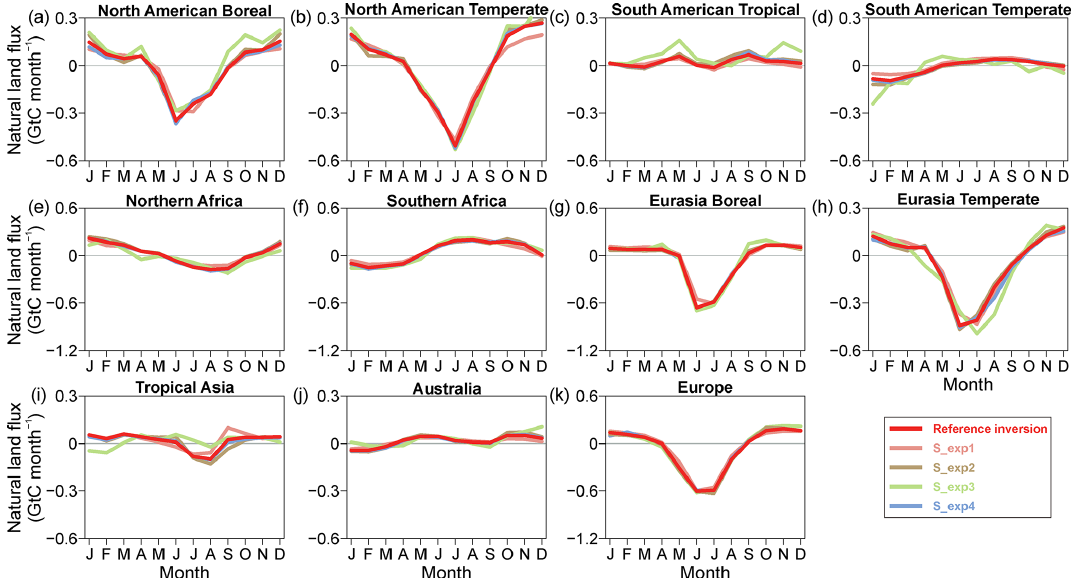
Figure 10. Seasonal cycle amplitudes of natural land fluxes over the 11 TransCom land regions derived from sensitivity inversions for 2015. The results of the reference inversion and four sensitivity inversions (please see Table 2) are represented by solid curves denoting the posterior natural land fluxes (i.e., terrestrial biospheric + fire fluxes) in 2015; the colors are the same as those shown in Fig.